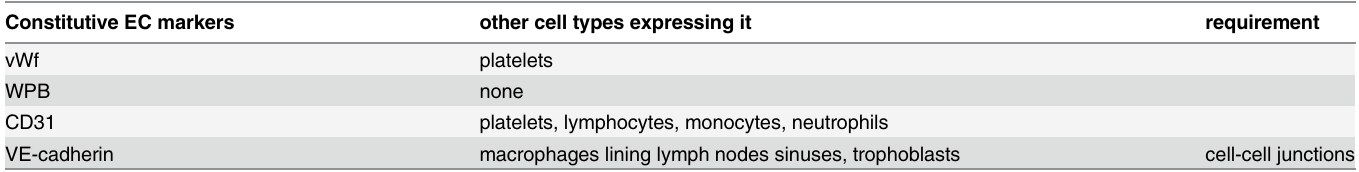
Table 1. An immunophenotypic analysis to correlate cell morphology and EC marker expression. Constitutive EC